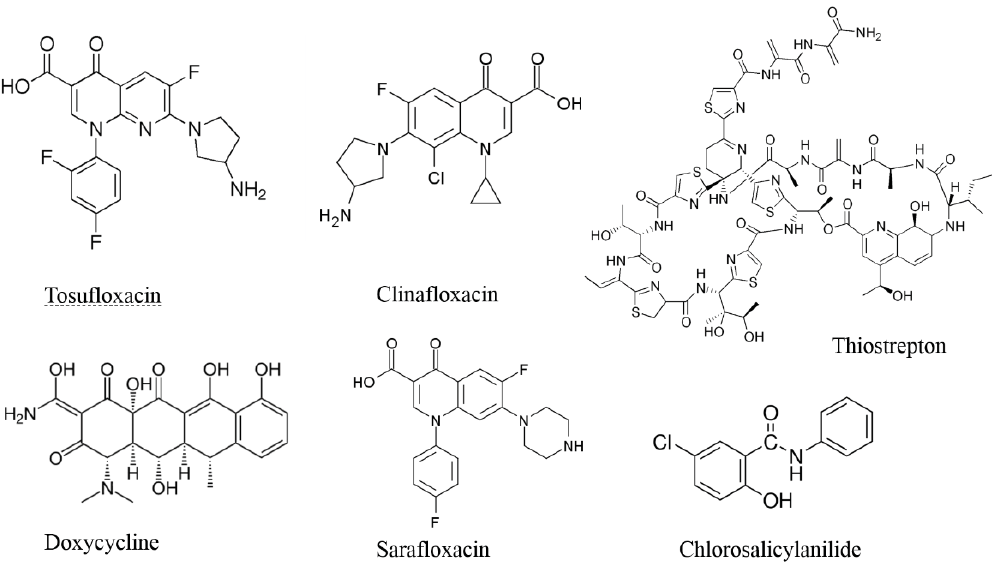
Figure 1. Structures of the six drug candidates with activity against S. aureus